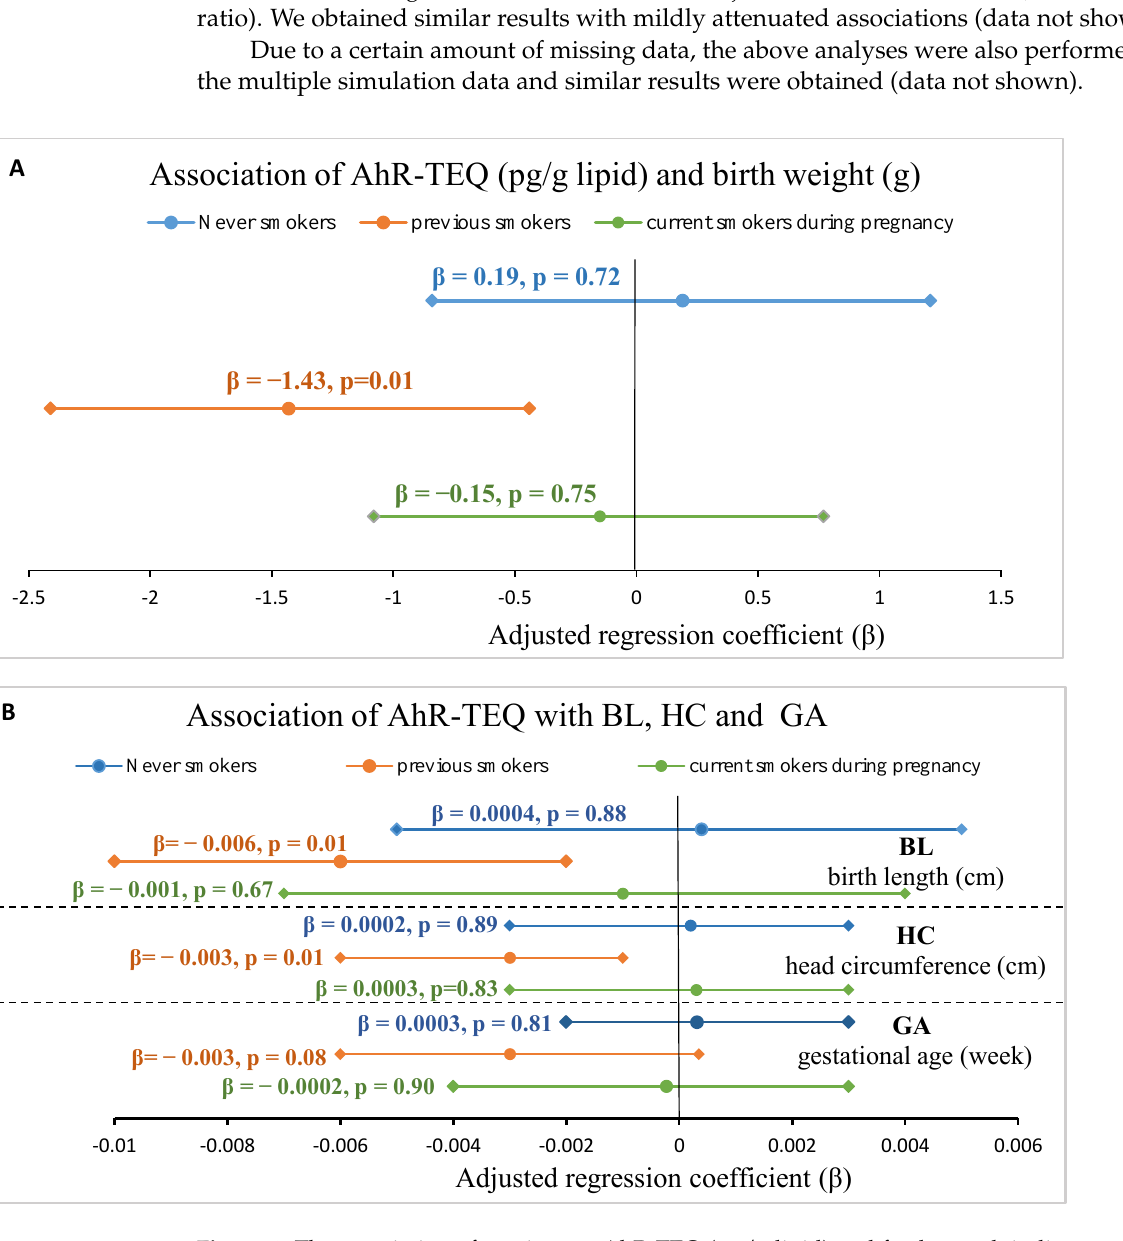
Figure 4. The association of continuous AhR-TEQ (pg/g lipid) and fetal growth indices stratified by maternal smoking history. ( A ) Association of AhR-TEQ and birth weight (g). ( B ) Association of AhR-TEQ and birth length (cm), head circumference (cm) and gestational age (week). The given regression coefficient was adjusted for maternal age, pre-pregnancy BMI, alcohol consumption during pregnancy and parity. Round circle: estimate (β) . Diamond circle: end of 95% CI.